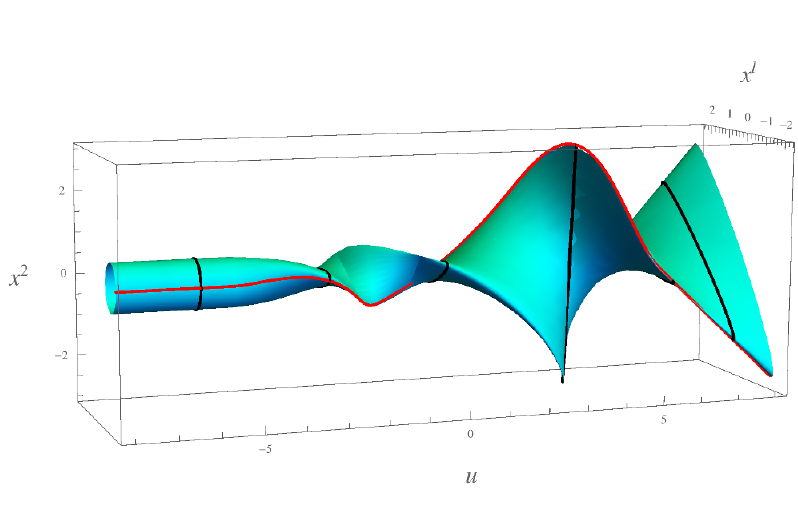
Figure 12 . The evolution of the Tissot circle through the passage of the gyraton. The red curve shows a single geodesic in the congruence as described in (cid:12)gure 11. In this case, the Tissot